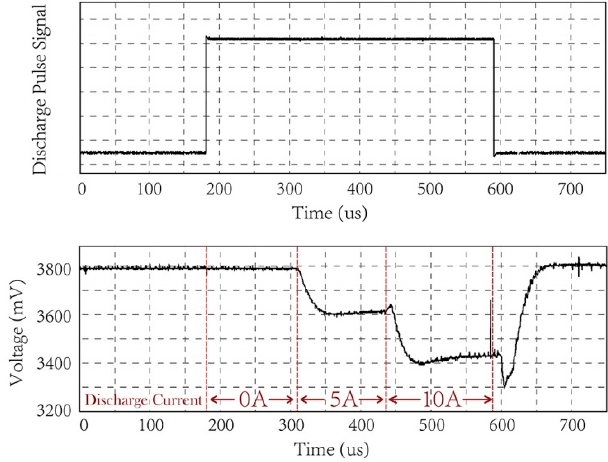
Figure 3 . Internal resistance detection oscilloscope diagram.